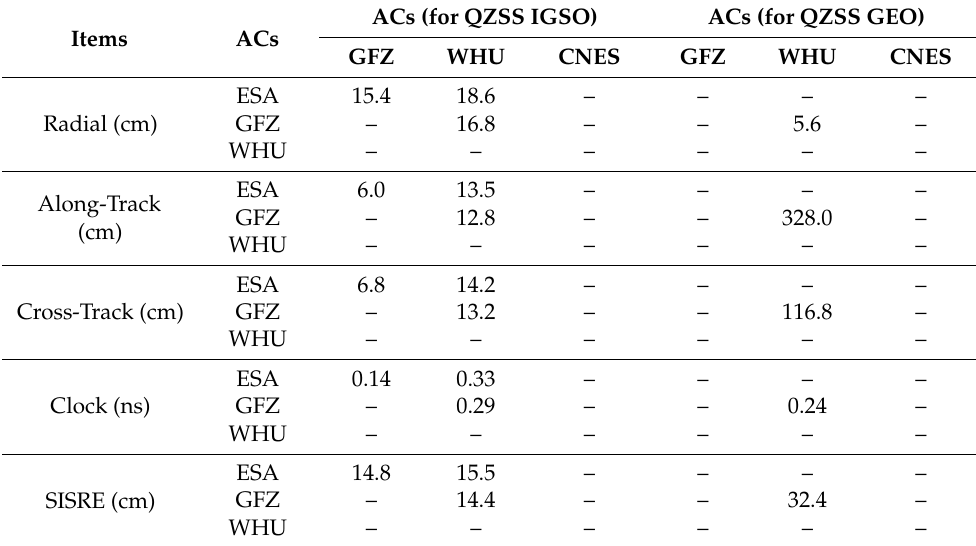
Table 7. RMSs of epoch-wise differences of precise satellite orbit and clock corrections among different ACs as well as SISRE statistics for QZSS IGSO and GEO satellites.